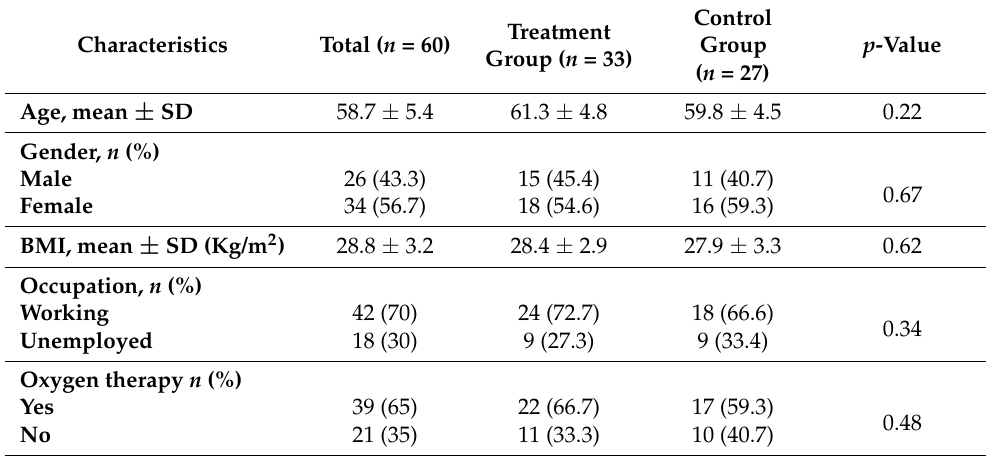
Table 1. General characteristics at baseline.